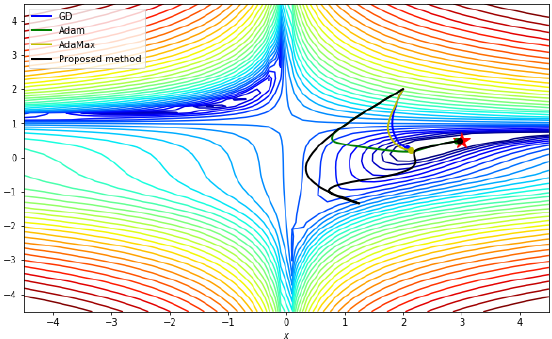
Figure 5. Result of the Beale function with an initial point of (2, 2). W 0 = ( 2,2 ) and the iteration number are 1000. The learning rate is 0.1 and the β 1 , β 2 , and λ used in proposed method are 0.9, 0.999, and − 0.5, respectively. GD’s learning late was set to 10 − 4 .